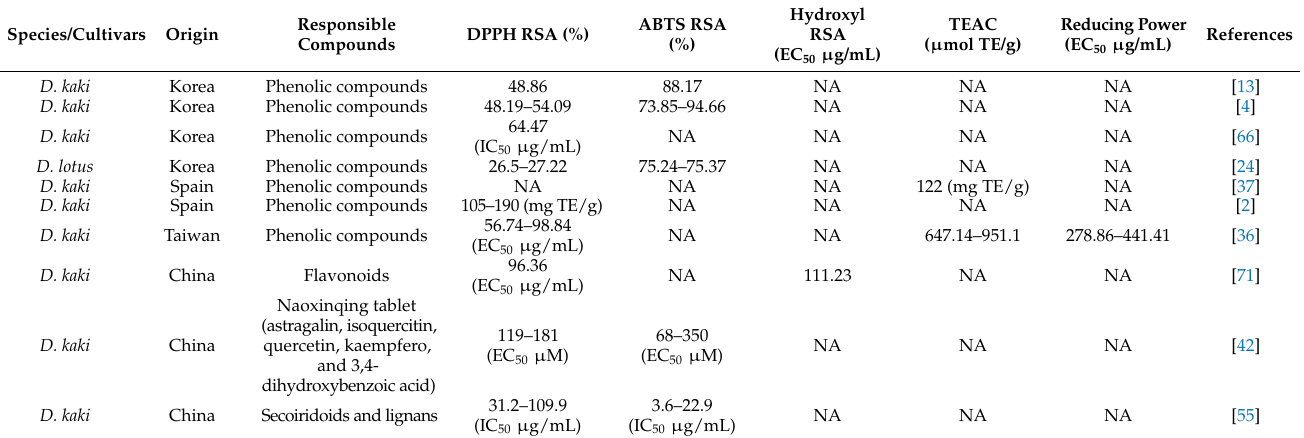
Table 3. Antioxidant activity of bioactive compounds extracted from